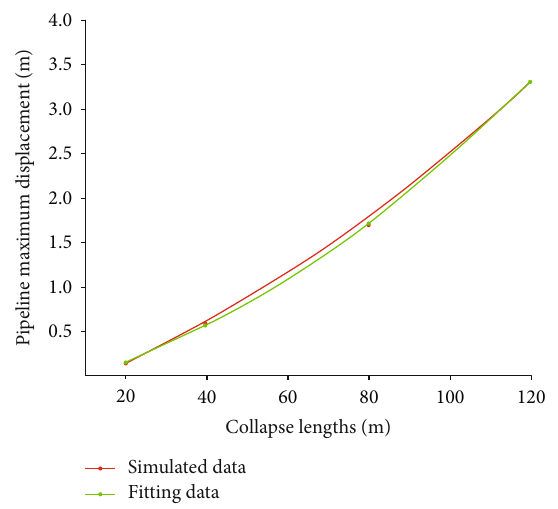
Figure 8: The pipeline maximum displacement under di ff erent collapse